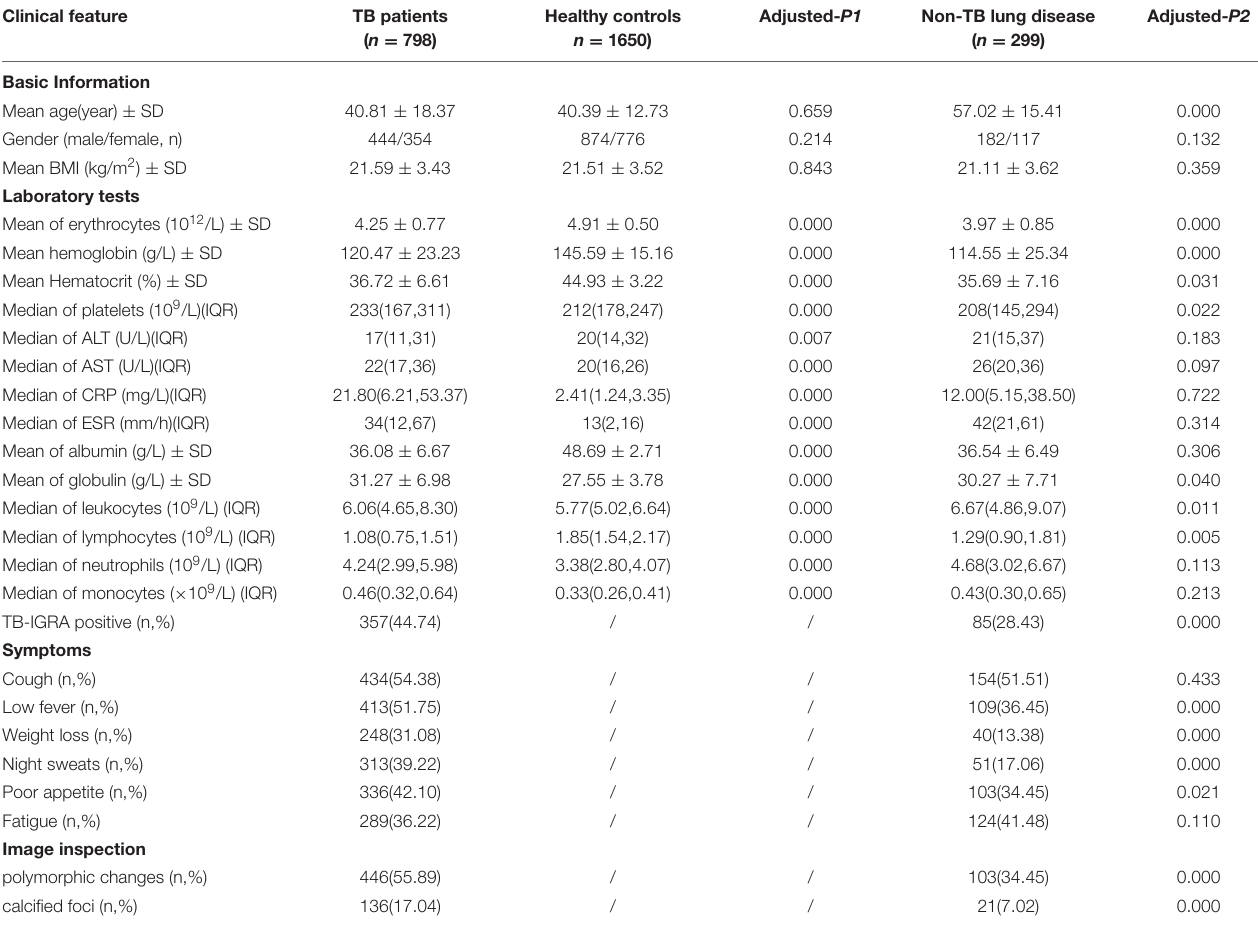
TABLE 2 | Demographic and clinical features in Selection